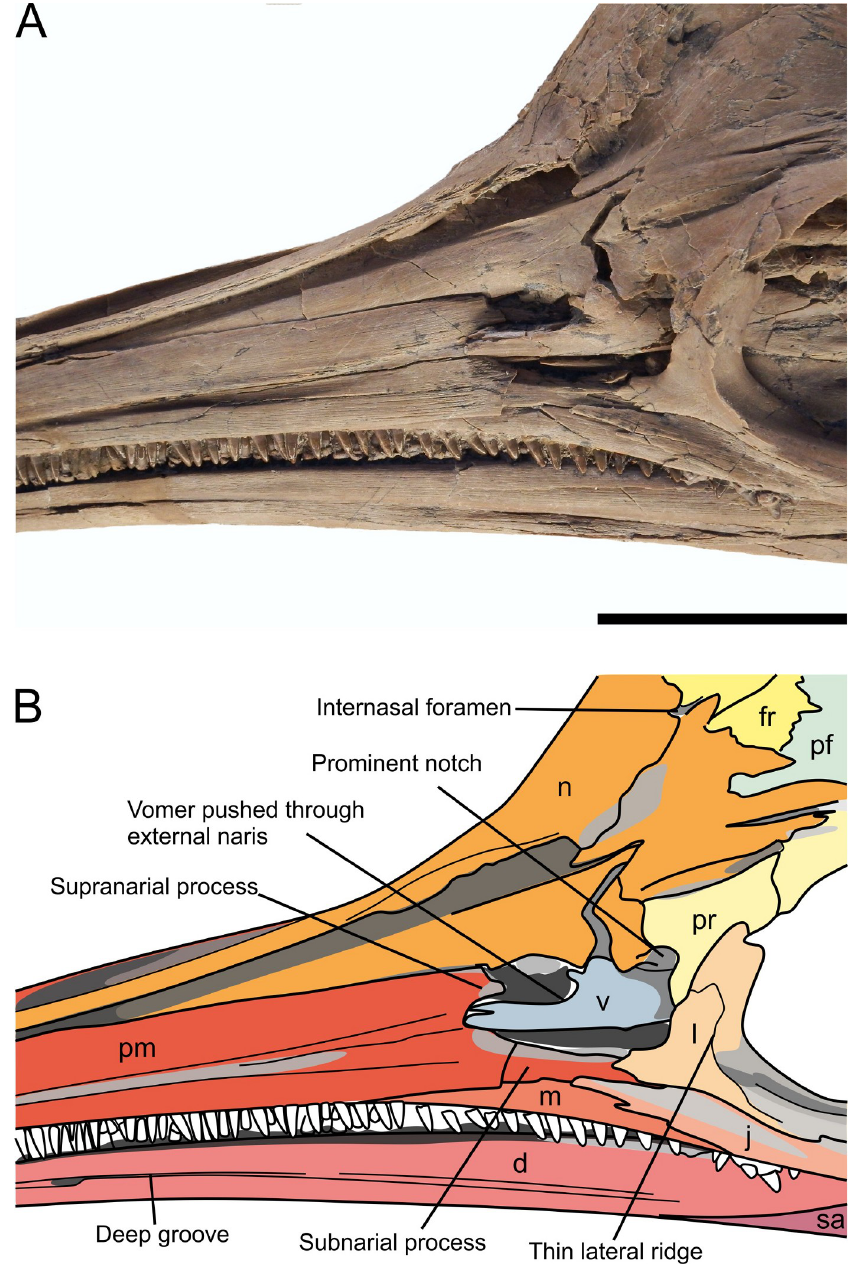
Fig 8. The anterior portion of the skull of Thalassodraco etchesi MJML K 1885. A, photograph of the anterior portion of the skull. B, annotated interpretation. See caption for Fig 7 for abbreviations. Scale bar 50 mm. contacts the posterior border of the external naris, with an anterior process contributing to part of the ventral border. Externally, the entire ventral margin contacts with the jugal. The dorsal border of the lachrymal ends abruptly with an sinusoidal suture with the prefrontal, dis- tinctly lacking irregular interdigitation (Fig 8). The posterior margin, which forms the antero- ventral border of the orbit is curved through an arc of approximately 115˚. Its contribution to the orbital rim forms a prominent thin lateral ridge that slopes obliquely in the centre of the